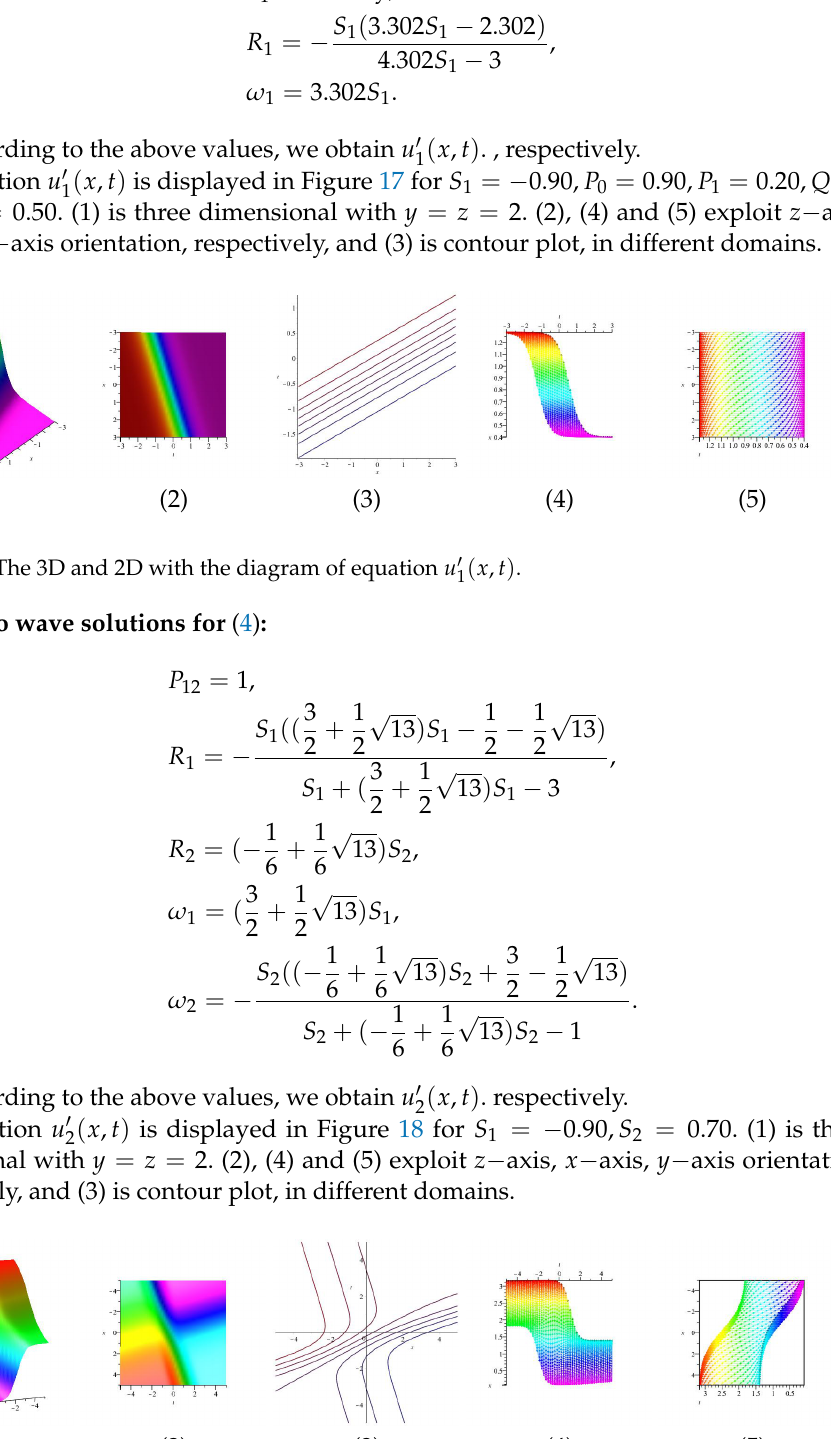
Figure 18. The 3D and 2D with the diagram of equation u (cid:48)